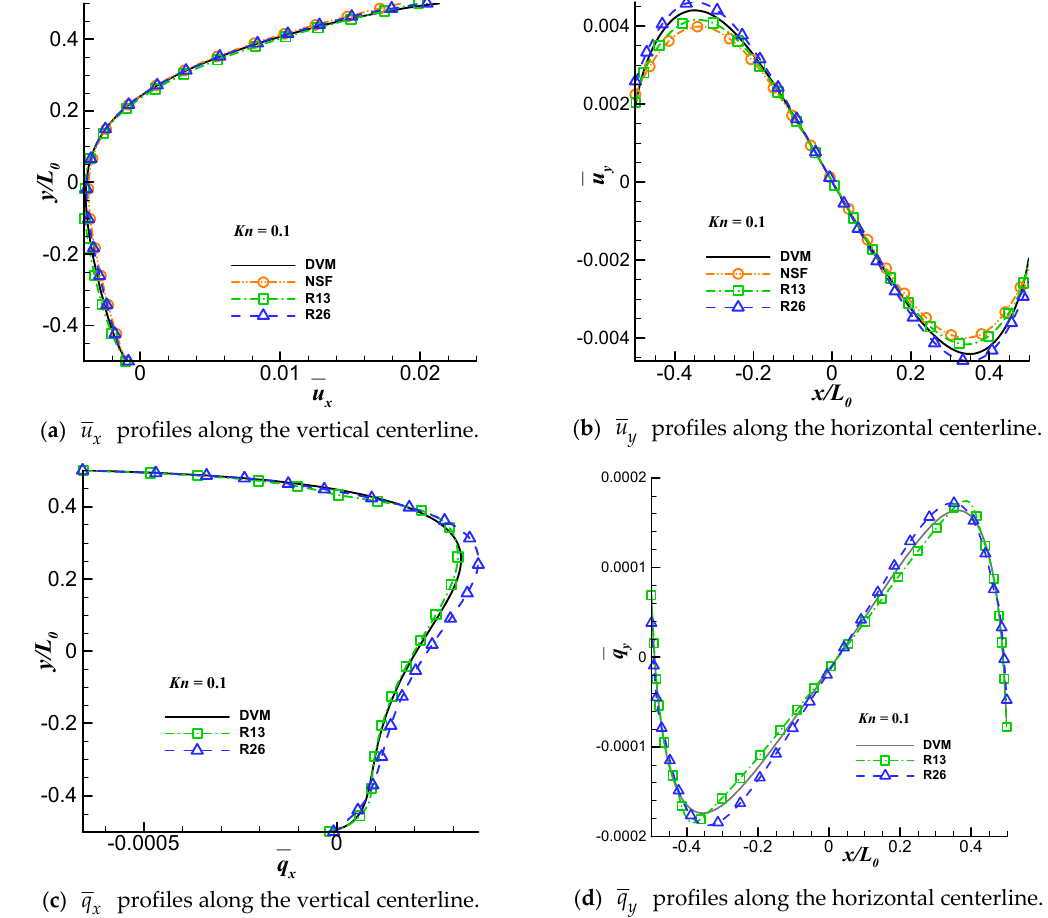
Figure 7. The simulation results of the cavity flow at = 0 1 Kn . .